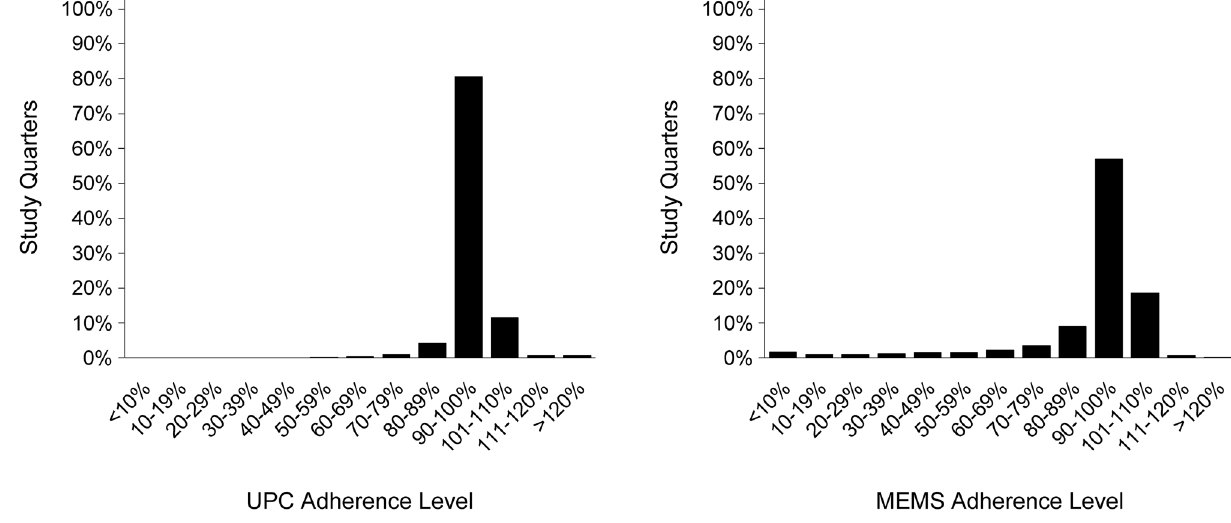
Figure 1. Distribution of adherence by unannounced pill count and electronic monitoring.